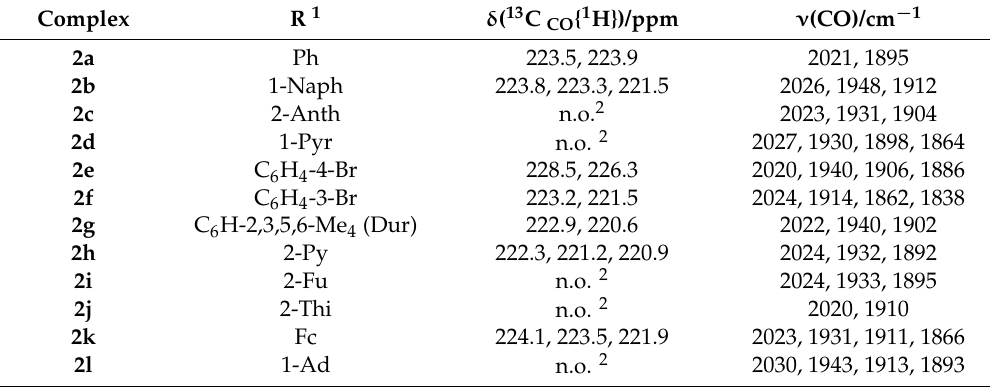
Table 1. Selected spectroscopic data of the carbonyl ligands of [(OC) 3 Mn(Br)(2-PyPz R H)] ( 2 ). The group R is bound in 5-position of the bidentate 3-(2-pyridyl)pyrazole ligand. Complex